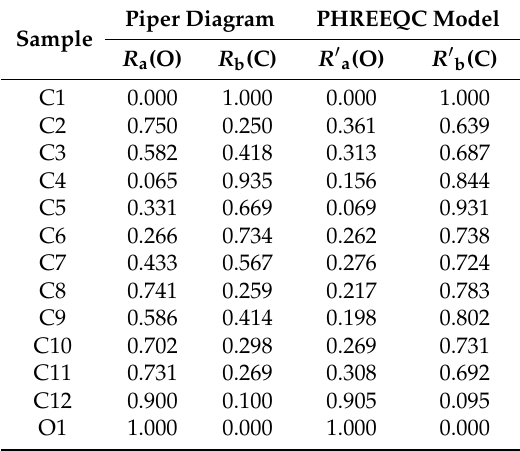
Table 4. Mixing ratios calculated by piper diagram and modified by PHREEQC